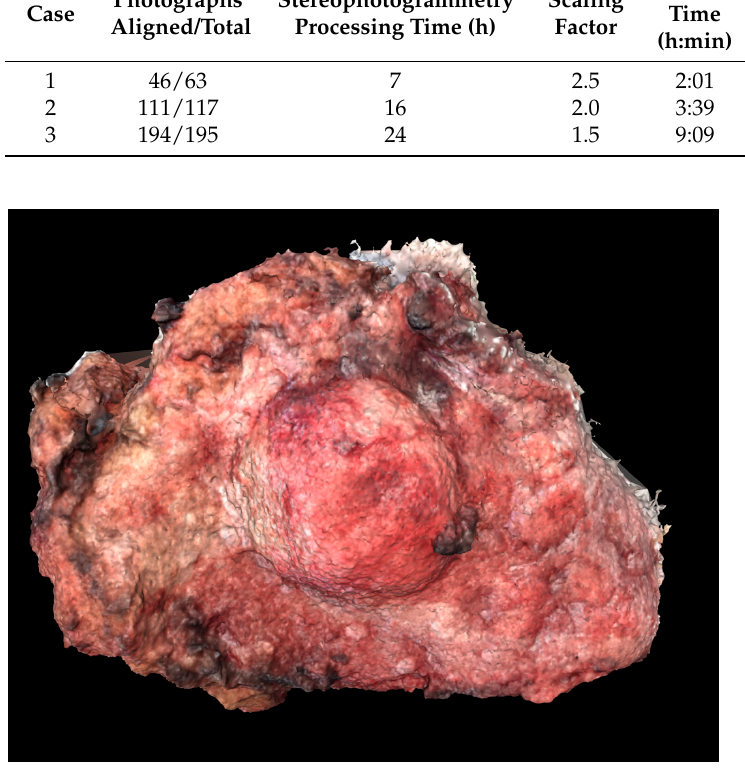
Figure 4. Digital 3D model of Case 1 using Meshlab.